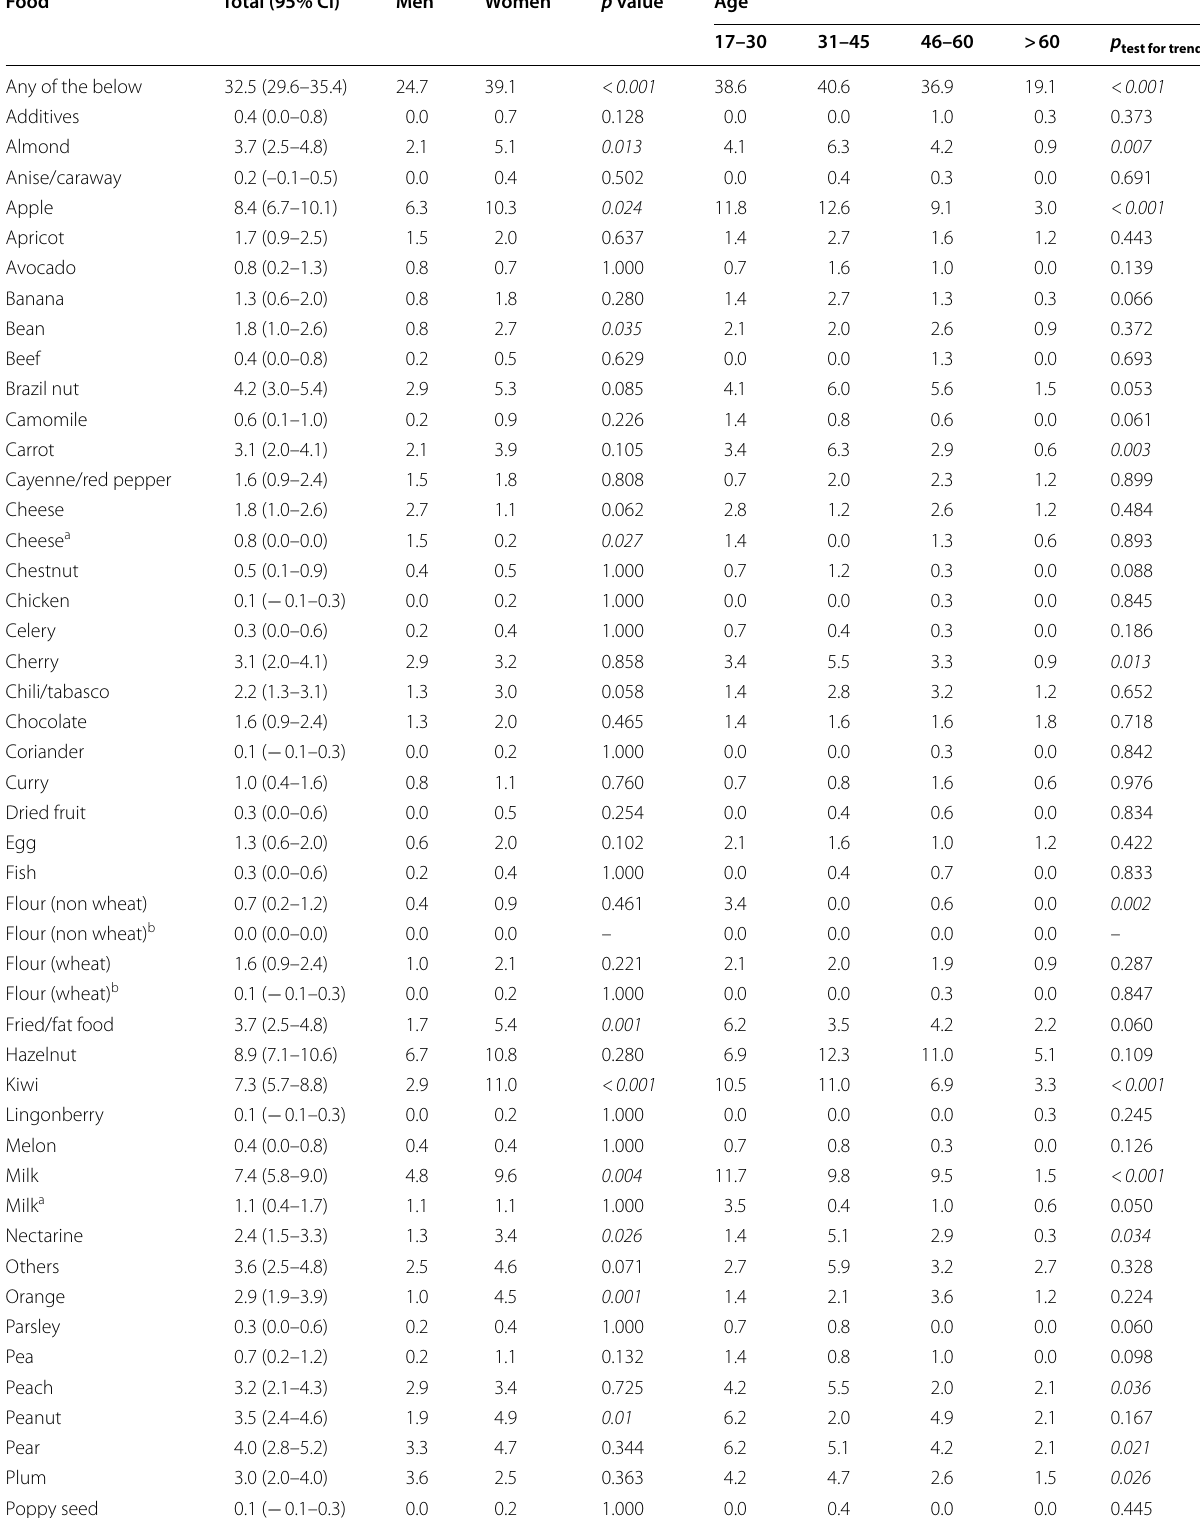
Table 3 Prevalence of self-reported symptoms for different foods, according to sex and age distribution (%)